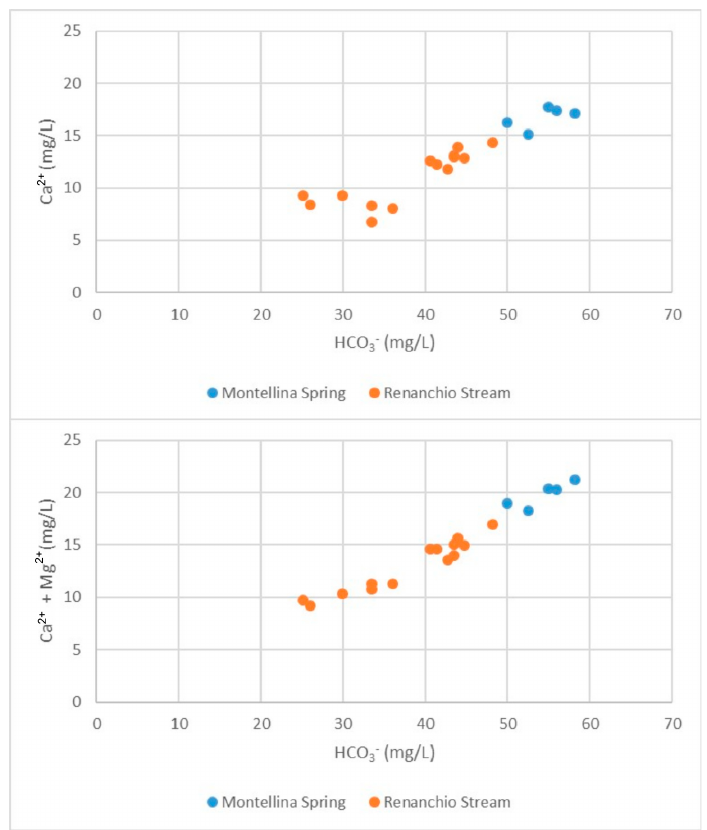
Figure 11. Plot of HCO 3 − versus Ca 2+ concentrations and HCO 3 − versus Ca 2+ + Mg 2+ concentrations in the groundwater and surface water of the investigated